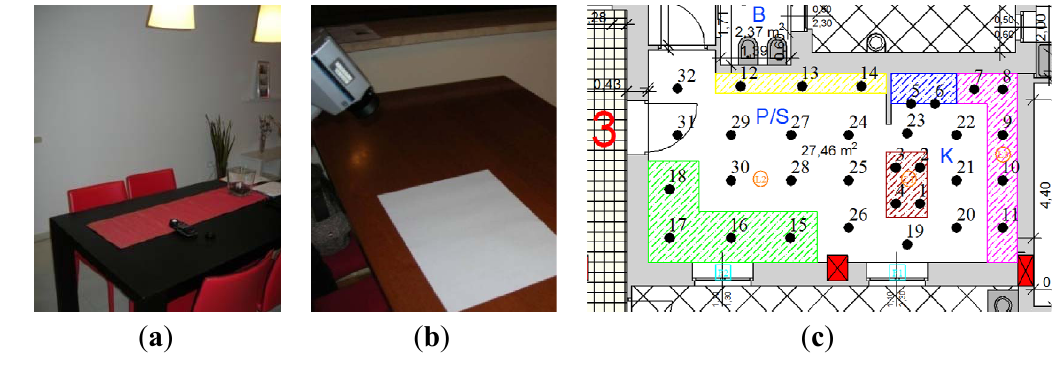
Figure 4. Experimental lighting measurements: ( a ) illuminance measurements by an illuminance-chroma-meter; ( b ) luminance measurements by a luminance-meter; and ( c ) grid for the measurements, main visual tasks (hatched area) and position of light source (L) and windows (F) in a monitored room in Building